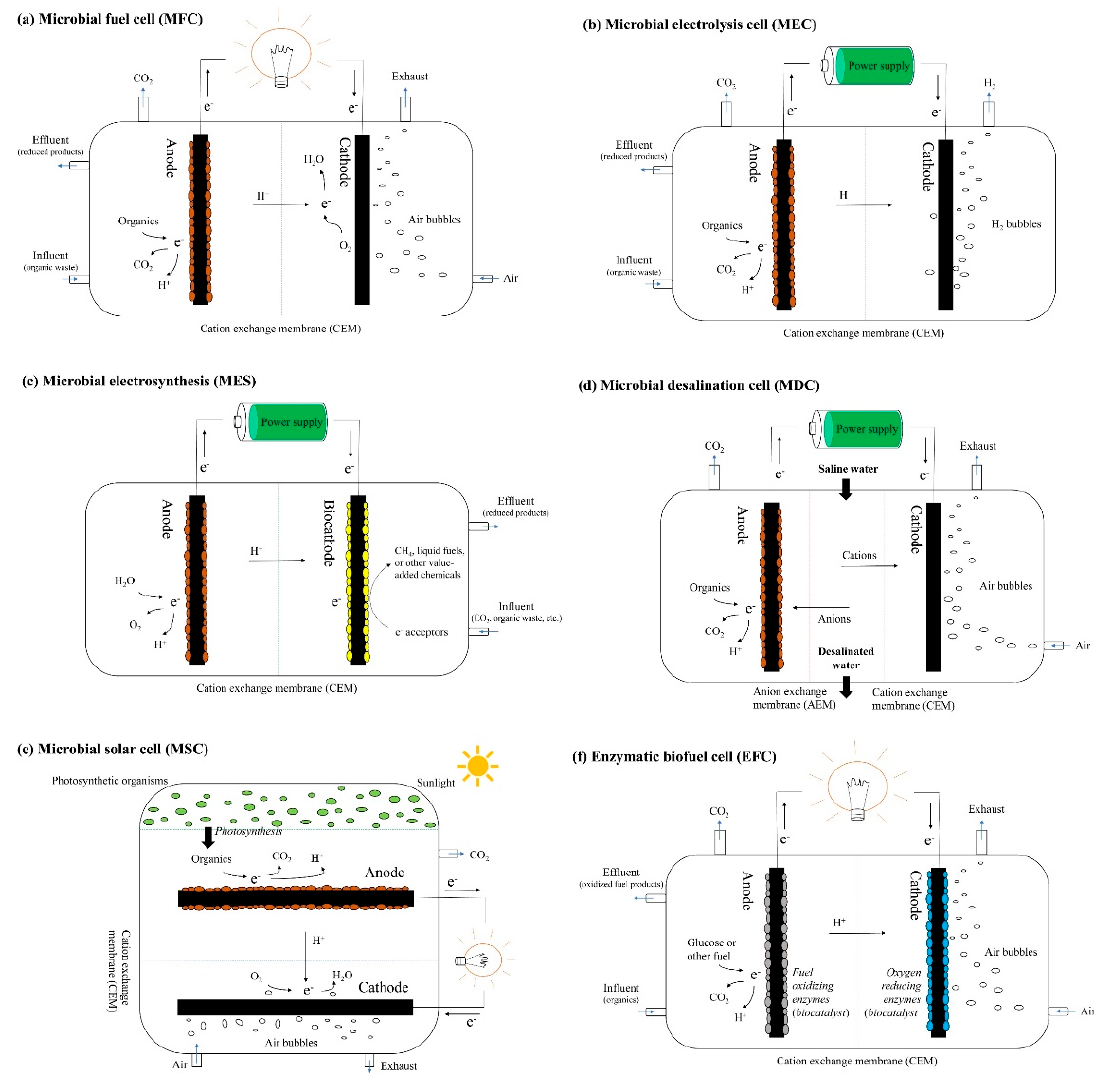
Figure 1. Different bioelectrochemical systems (BESs) classified by application purposes.